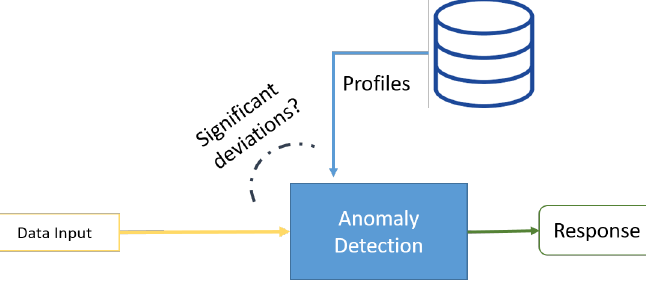
Figure 3. Diagram of a generic anomaly-based IDS.